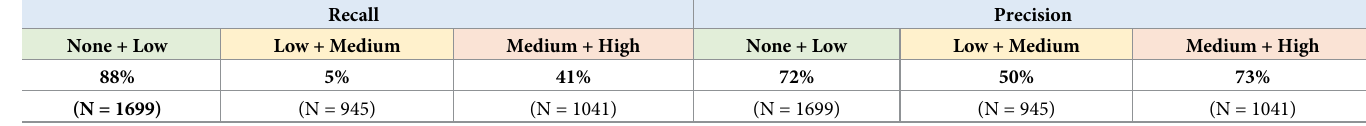
Table 6. Recall and precision of random forest model predicting aggregate opioid requirements. Prediction results prior to surgery are shown.